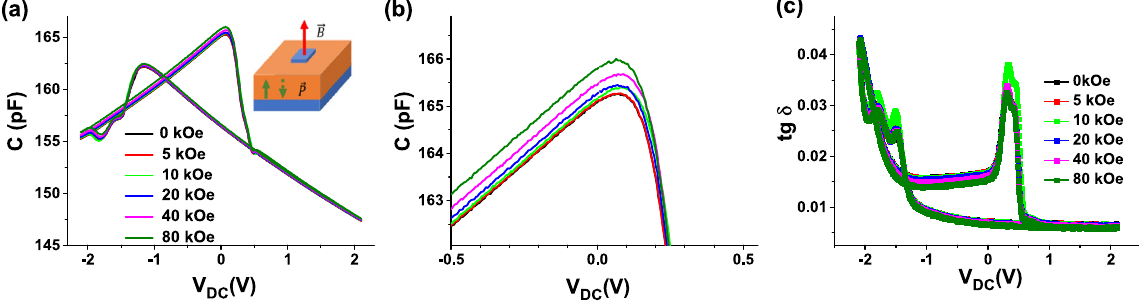
Figure 1. ( a ) Capacitance-voltage characteristics at different magnetic field acquired at 75 K and 1 kHz on a LSMO-PZT-LSMO sample with 50 nm PZT film thickness; ( b ) a zoom-in of ( a ) in the peak region associated with the polarization switching. The inset in ( a ) shows the measurement geometry; ( c ) Dielectric loss-voltage characteristics acquired at different magnetic